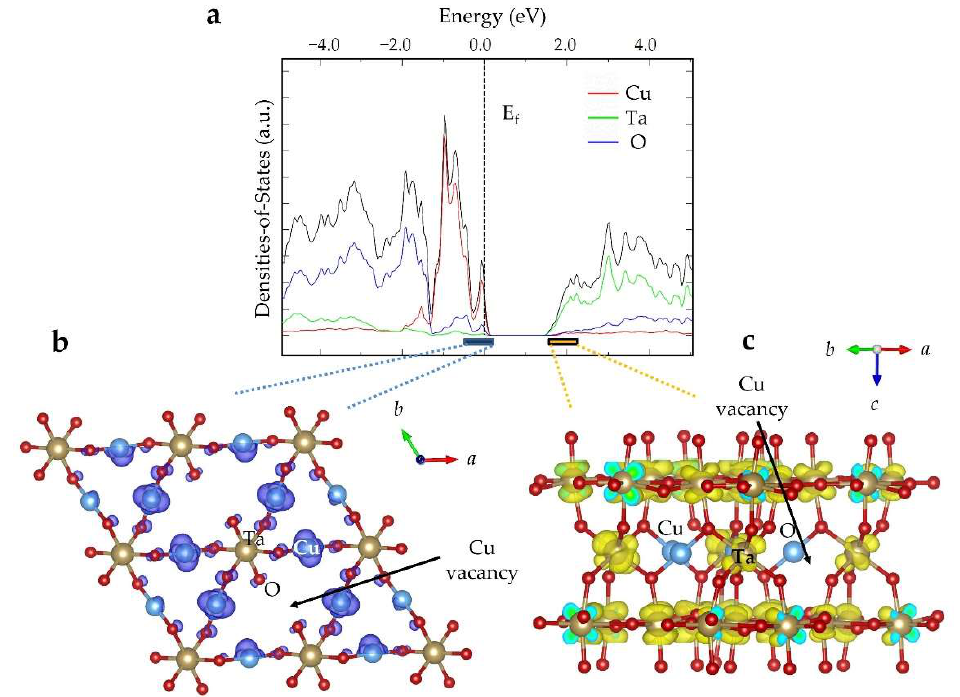
Figure 7. Cu (3−x) Ta 7 O 19 (x = 0.33), the ( a ) calculated densities-of-states, with the atomic orbital contributions and Fermi level (E f ) labeled, and the electron density contributions to the ( b ) valence band edge (blue bar, colored) and ( c ) conduction band edge (yellow bar, colored).